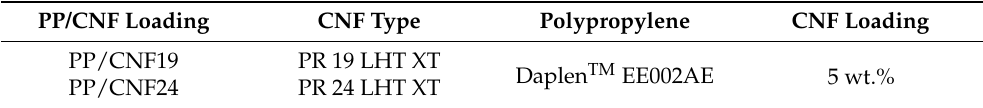
Table 1. CNFs and PP/CNF